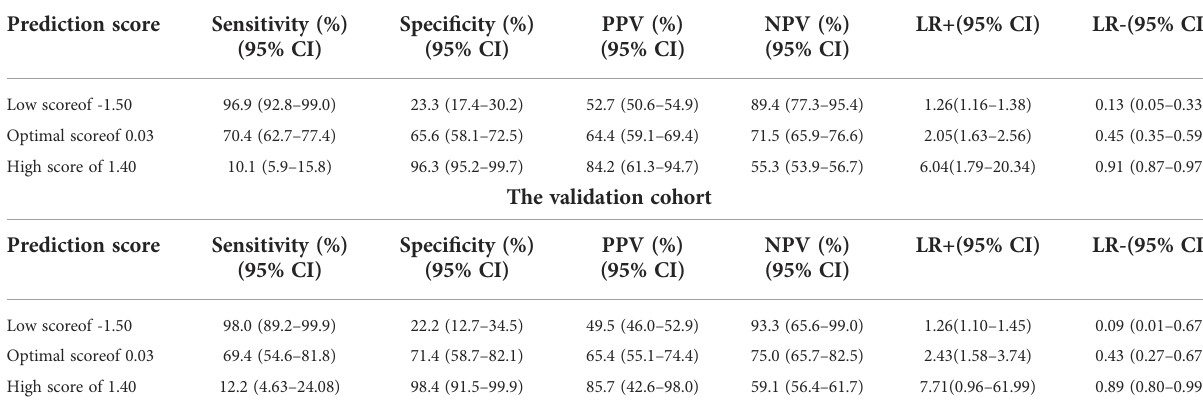
TABLE 4 The diagnostic performance of the 90-day mortality prediction model following endobiliary stent placement in the derivation and validation cohorts. The derivation